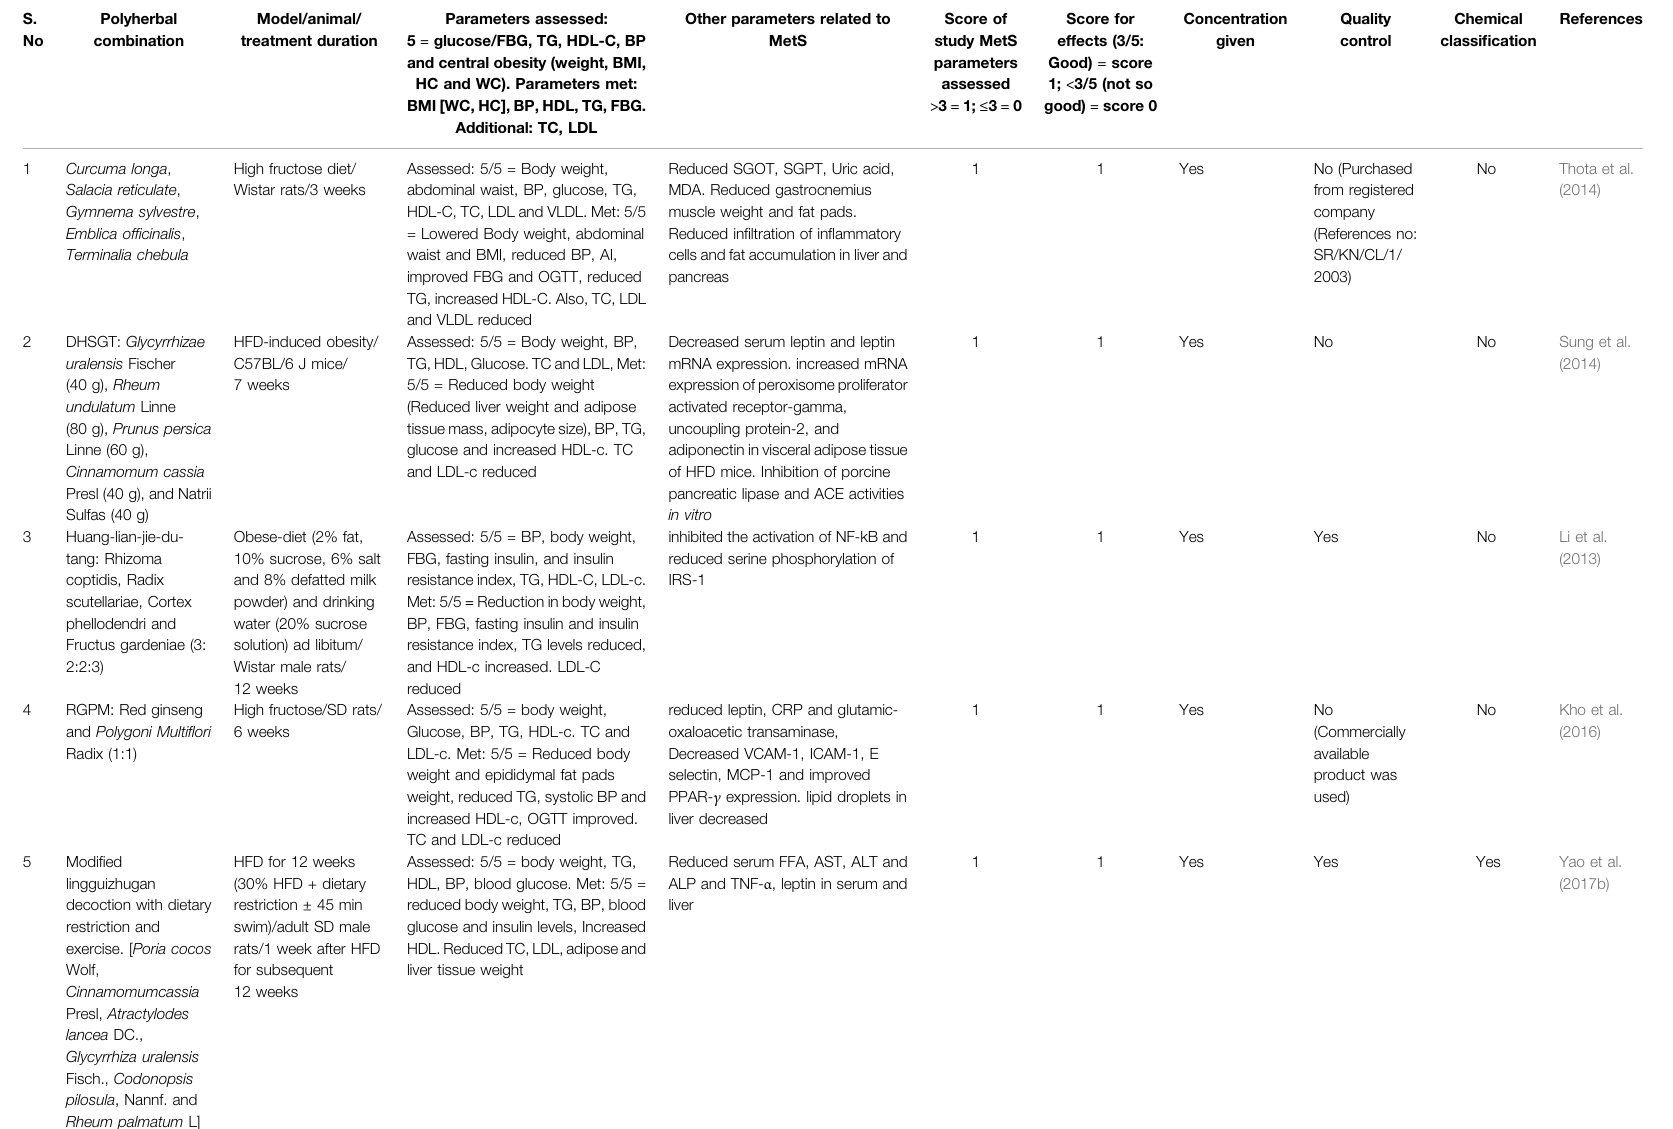
TABLE 3 | Summary of metanalysis of Poly herbal combinations used in animal-based models of Metabolic